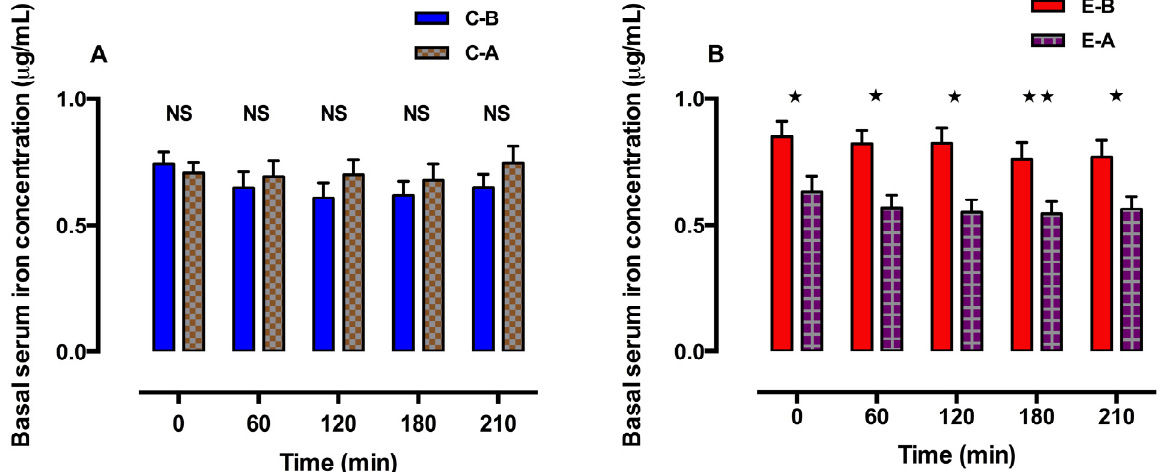
Figure 3. Basal serum iron concentrations in the control group ( A ) and experimental group ( B ) before and after 3 mo of placebo or oral zinc supplementation. Concentrations are expressed as the mean ± SEM. p values were calculated using Tukey’s multiple comparisons test. All comparisons were considered to be statistically significant at the 5% level ( p < 0.05). NS = not significant. * p < 0.0001. ** p = 0.0007.